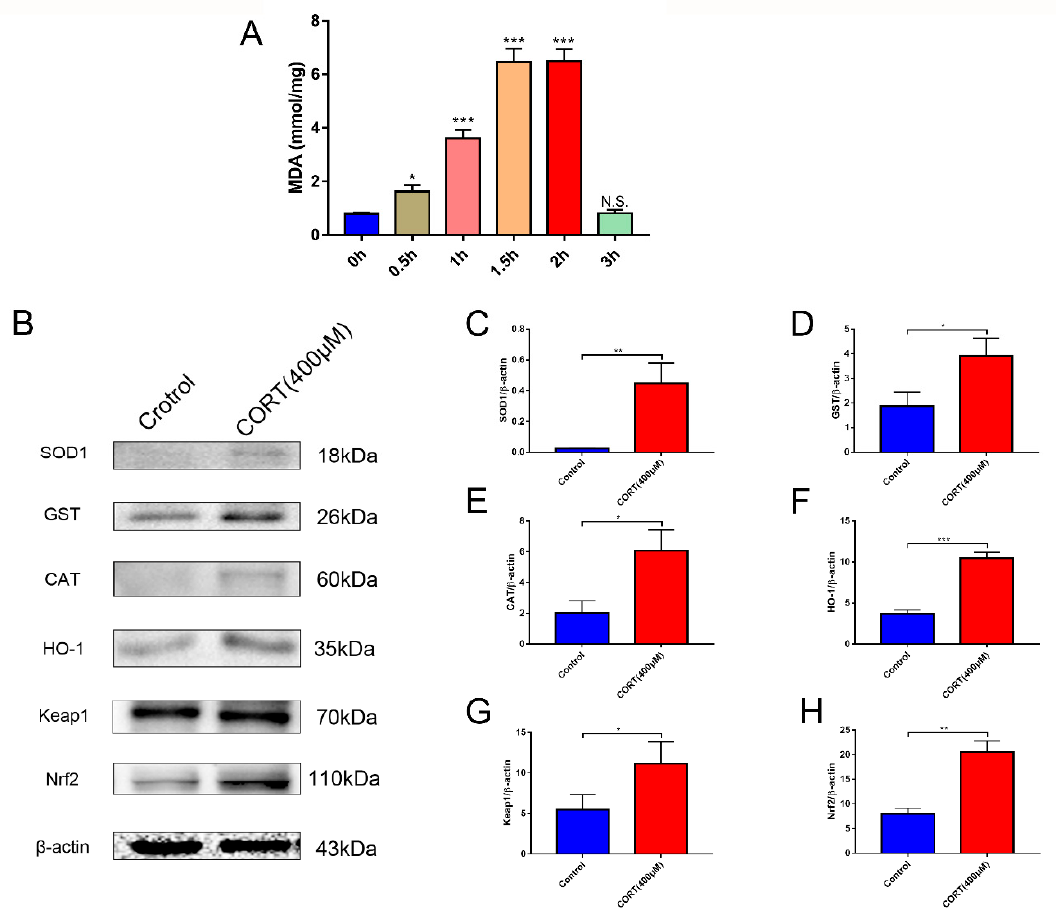
Figure 10. The levels of malondialdehyde (MDA) were measured in HT22 cell lysates after cortisol (CORT) treatment for 3 h. The bar graph shows the MDA level at every time point ( A ). Data were between control (CORT 0 µ M) vs. CORT (400 µ M), and were analyzed by one-way analysis of variance. The results are expressed as the mean ± SD ( n = 3) in each independent experiment. NS: not significant; * p < 0.05; *** p < 0.001. The relevant expression of anti-oxidative proteins in HT22 cell lysates after CORT treatment for 3 h as assessed by western blotting and relative density analysis ( B ) SOD1, GST, CAT, HO-1, Keap1, Nrf2, and β -actin expression (control) in each group. Expression levels were quantitated by measuring band intensities using Image Lab software. The graphs indicate densitometric analyses using the expression ratios of ( C ) SOD1 / β -actin, ( D ) GST / β -actin, ( E ) CAT / β -actin, ( F ) HO-1 / β -actin, ( G ) Keap1 / β -actin, and ( H ) Nrf2 / β -actin. Data were between control (CORT 0 µ M) vs. CORT (400 µ M), and were analyzed by one-way analysis of variance. The results are expressed as the mean ± SD ( n = 3) in each independent experiment; * p < 0.05; ** p < 0.01; *** p < 0.001.